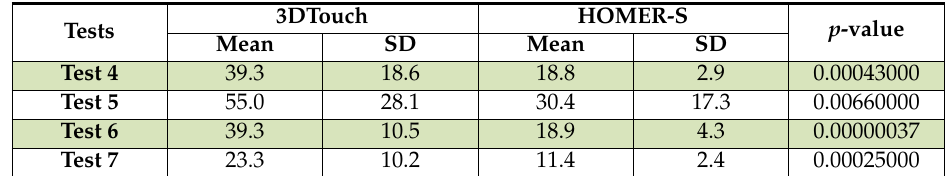
Table 3. Phase Two: 3DTouch and HOMER-S